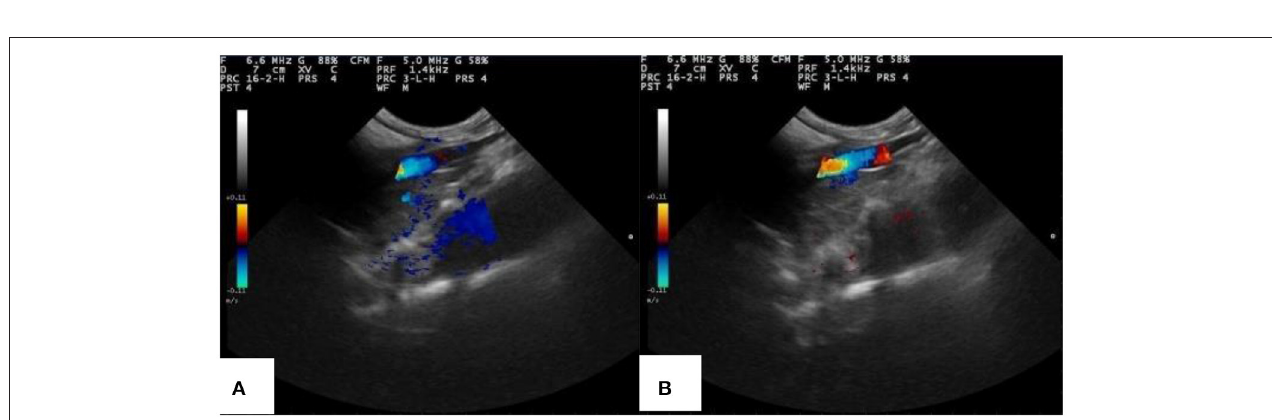
FIGURE 9 | Ultrasonic imaging of rabbit abdominal aorta of rabbits injected with PLA combined Fe 3 O 4 -GO-ASA nanobubbles of the different concentrations (A) 0 mg · mL − 1 (B) 20 mg · mL − 1 (C) 60 mg · mL − 1 (D) 100 mg · mL − 1 .